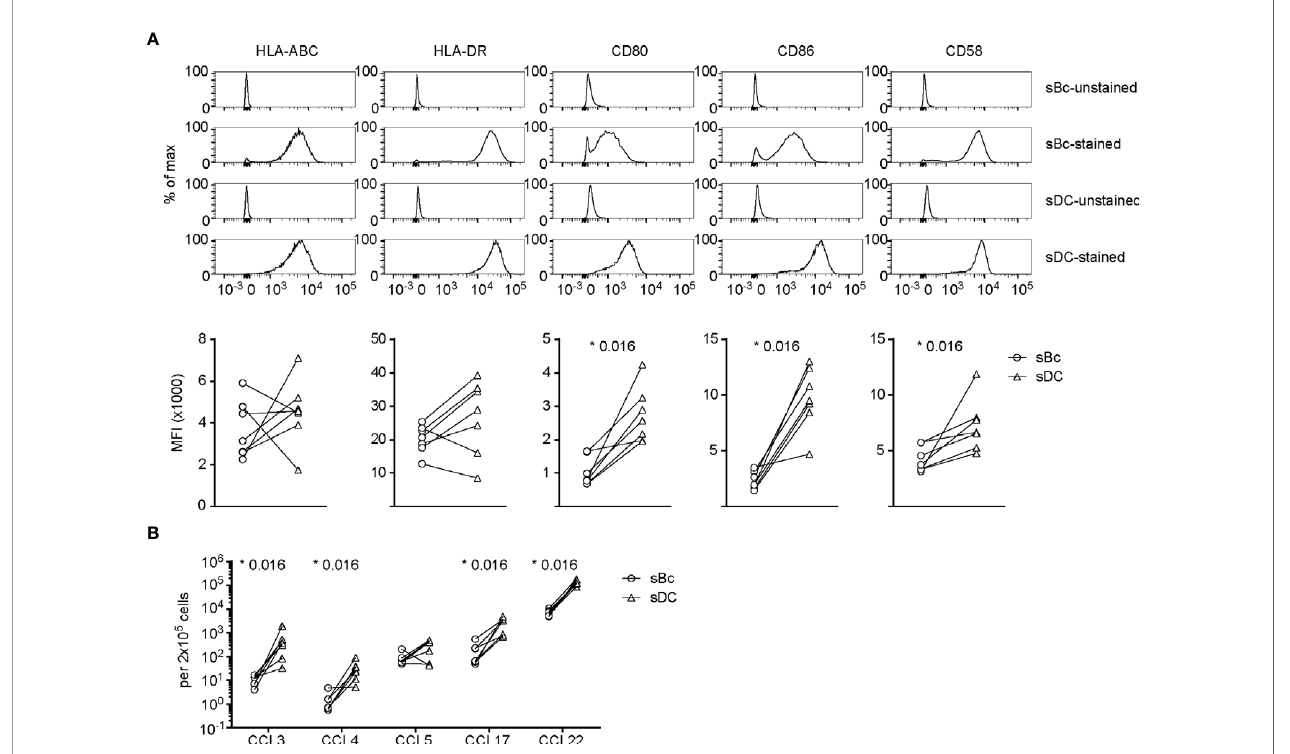
FIGURE 2 | sDCs, comparedto sBcs, express higher levels of costimulatory molecules and secrete more T cell-attracting chemokines. (A) Expression ofcell surface molecules on sBcs and sDCs. Cells were stained withantibodies ( “ sBc-stained ” and “ sDC-stained ” ), or were not stainedwithantibodies ( “ sBc-unstained ” and “ sDC- unstained ” ) for reference. Representative histograms (top row) andlevel of expression(MFI) (bottom row) ofcell surface molecules on sBcs and sDCs. (B) Secretion of chemokines bysBcs and sDCs. sBcs and sDCs were plated alone at the same density usedto culture puri fi edT cells(200,000 sBcs or 12,500 sDCs in 100µLassay medium). After 48 h, the culture supernatants were harvested and tested for the indicated molecules using Luminex assay. Data in (A, B) contain 7 different sBc:sDC pairs. Connecting lines indicate sBcs and sDCs derived from the same donor. Statistics were performedbetween sBcs and sDCs using theWilcoxonmatched-pairs